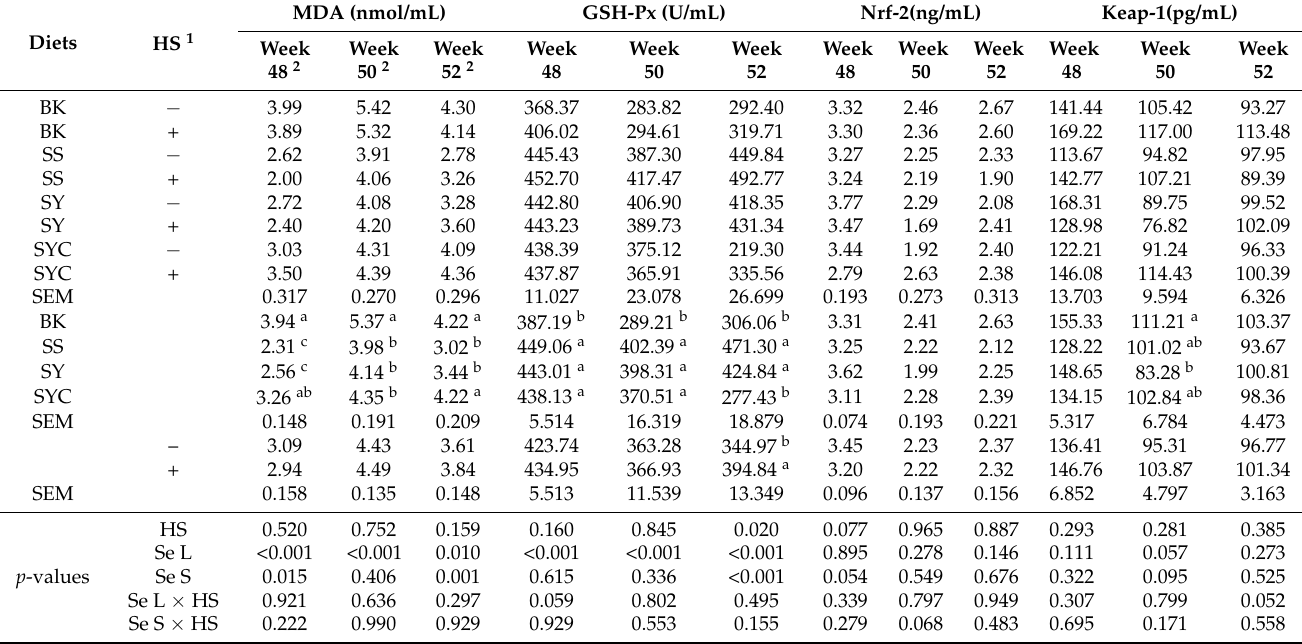
Table 6. Effects of dietary different Se sources on serum antioxidant status of laying